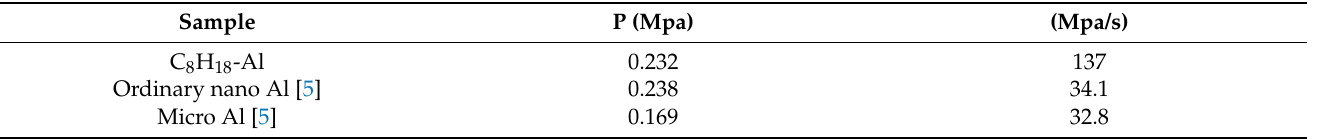
Table 4. Combustion performance comparison of